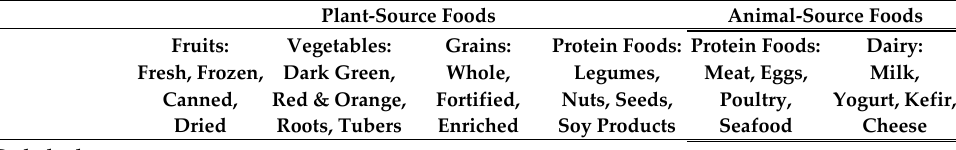
Table 1. Macronutrients Commonly Associated with Plant-Source and Animal-Source Foods.